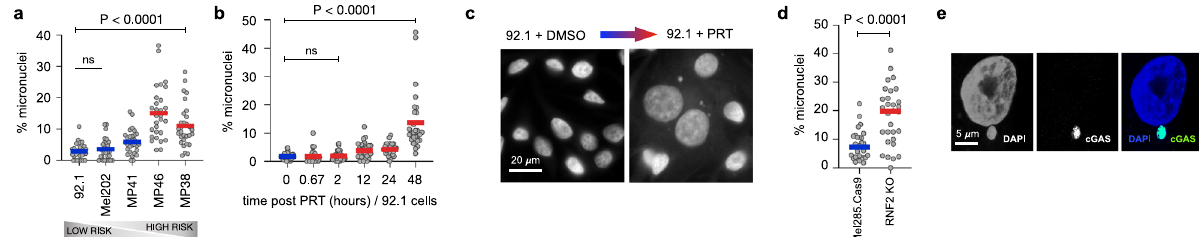
Fig. 6 Cytosolic DNA exposure in high-risk UM. a Baseline micronuclei frequency across UM cell lines, arranged from left to right based on their GEP2 score. Bar represents median; points, measured frequency of micronuclei per high-power fi eld evaluated across three experimental replicates. Statistical signi fi cance tested using two-sided student t test; p = 2.8 × 10 − 8 . Source data are provided as a Source Data fi le. b Micronuclei frequency in low- risk UM cells (92.1) upon PRT treatment as a function of time. For ( a , b ), bar represents median; points, measured frequency of micronuclei per high-power fi eld evaluated across three experimental replicates. Statistical signi fi cance tested using two-sided student t test; p = 7.7 × 10 − 8 . Source data are provided as a Source Data fi le. c Low-risk UM cells (92.1) stained for DAPI (white); showing increased nuclear size and micronuclei formation upon PRT-treatment. Images representative of experimental triplicates. d Micronuclei frequency in UM cells (Mel285.Cas9) upon RNF2 knockout. Bar represents median; points, measured frequency of micronuclei per high-power fi eld evaluated across three experimental replicates. Statistical signi fi cance tested using two-sided student t test; p = 7.7 × 10 − 6 . Source data are provided as a Source Data fi le. e An example of a cGAS (green) localization to micronuclei (blue). Representative image from biological